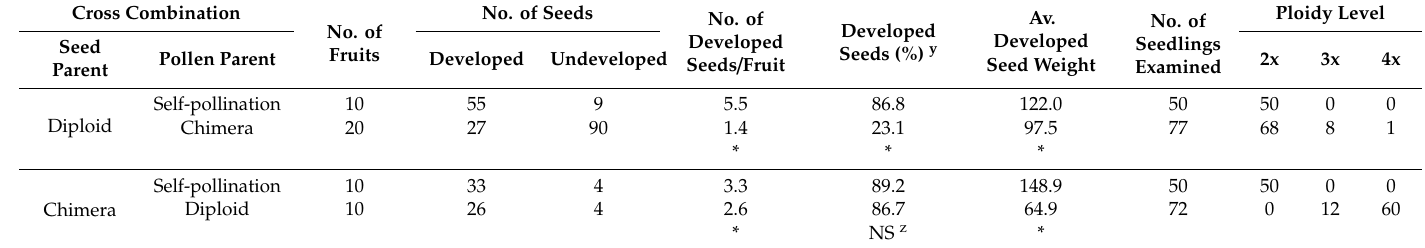
Table 5. Comparison of morphological characteristics of fruits in the diploid, the tetraploid, the Yubeni, and the chimera of the Meiwa kumquat. Fruit (mm) Shape SSC ( ◦ Brix) TA of No. of No. of Pericarp Developed Fruit Pericarp Ploidy No. of Developed Undeveloped Wt. / Fruit Seeds / Fruit Pericarp Index of Juice Wt. (g) Wt. (g) Level Locules (%)Diameter Height Pericarp Seeds / Fruit Seeds / Fruit Wt. (%) (%) Fruit z Sac Diploid 2x 22.2 0.26 Yubeni 2x + 4x 24.8